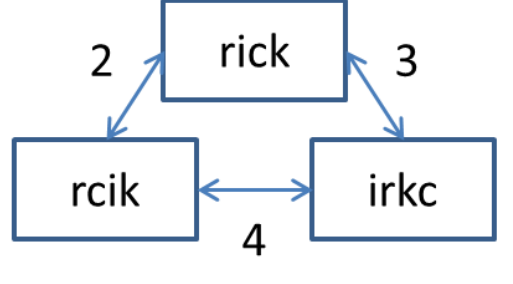
Figure 3 . Example of Levenshtein Distance